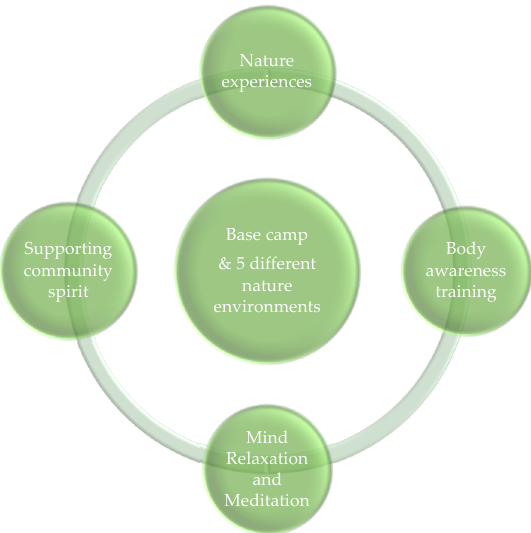
Figure 1. The elements in the Nature–Body–Mind–Community approach in the ‘Wildman Programme’.